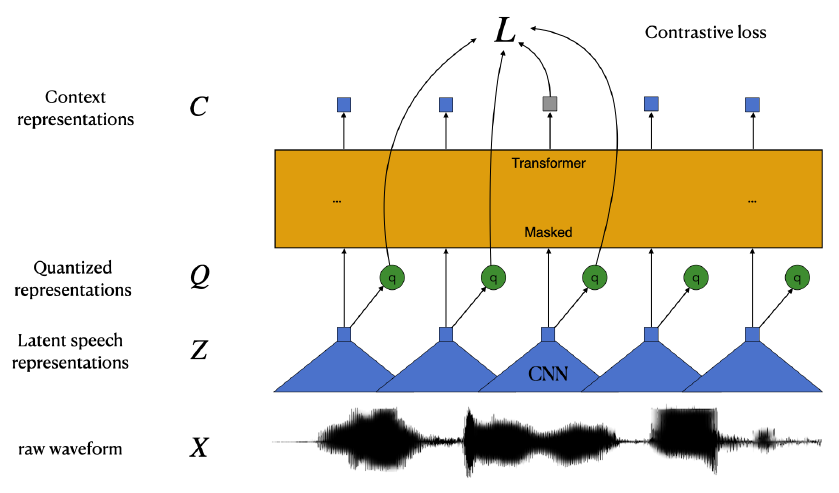
Figure 3. The figure illustrates the wav2vec 2.0 framework, which aims to learn both contextualized speech representations and an inventory of discretized speech units in a joint